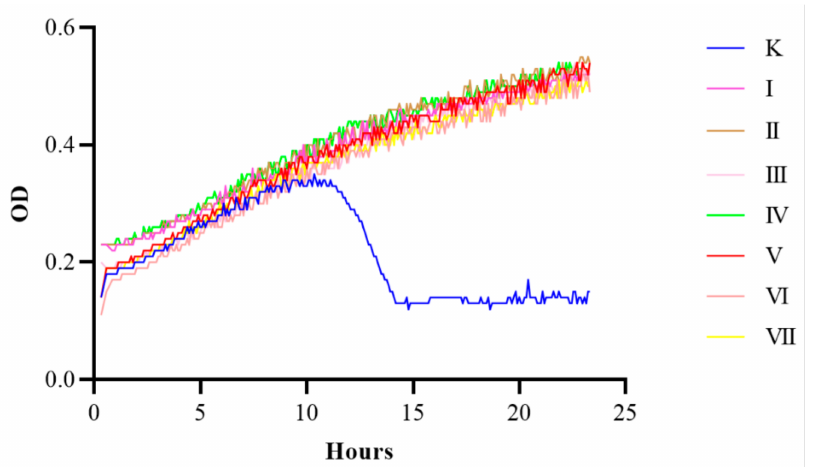
Figure 5. OD over time for P. syringe incubated with phi6 phages after their incubation with the chosen coatings (phages were added when OD = 0.2, amount of phage MOI =